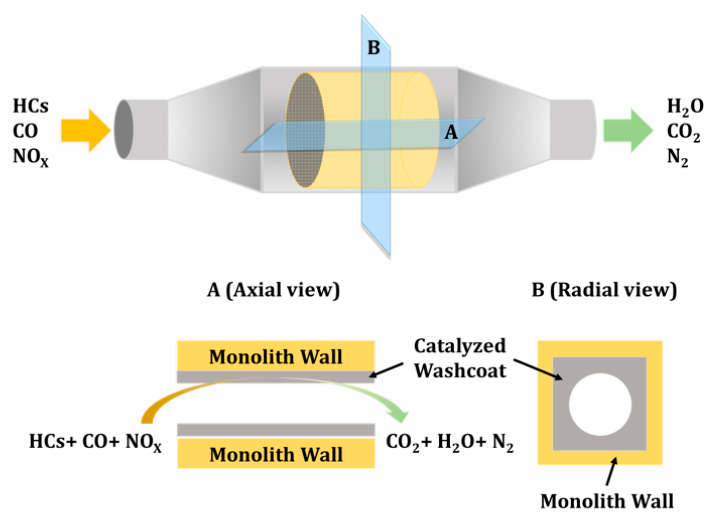
Figure 1. A washcoated monolith automotive TWC